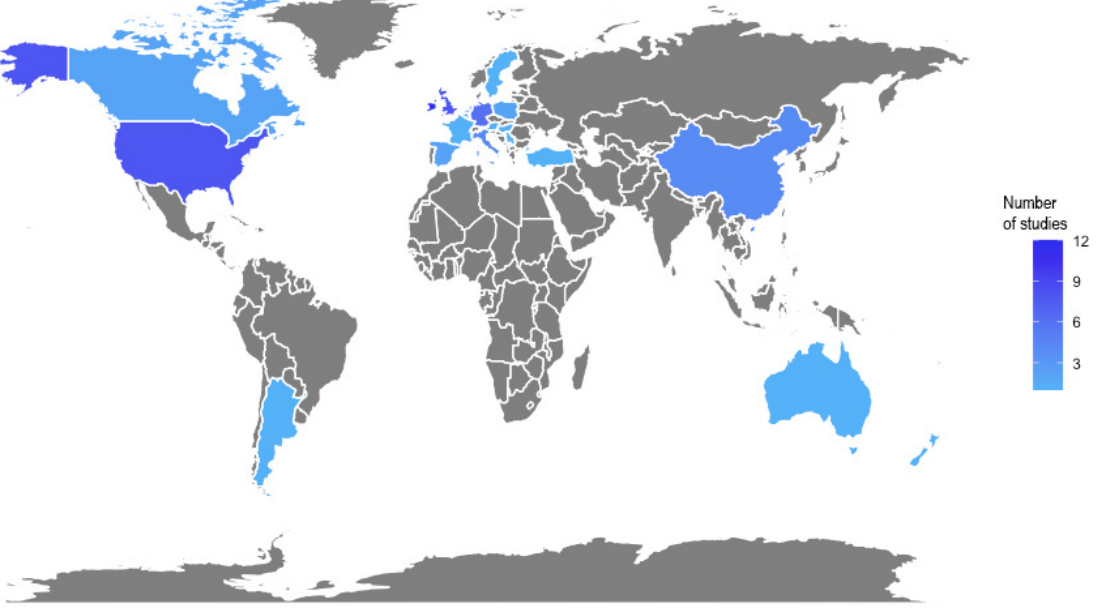
Figure 2. Origin of data used in the studies identified in the systematic literature search on machine learning in dairy science. Only original research considered (no reviews).